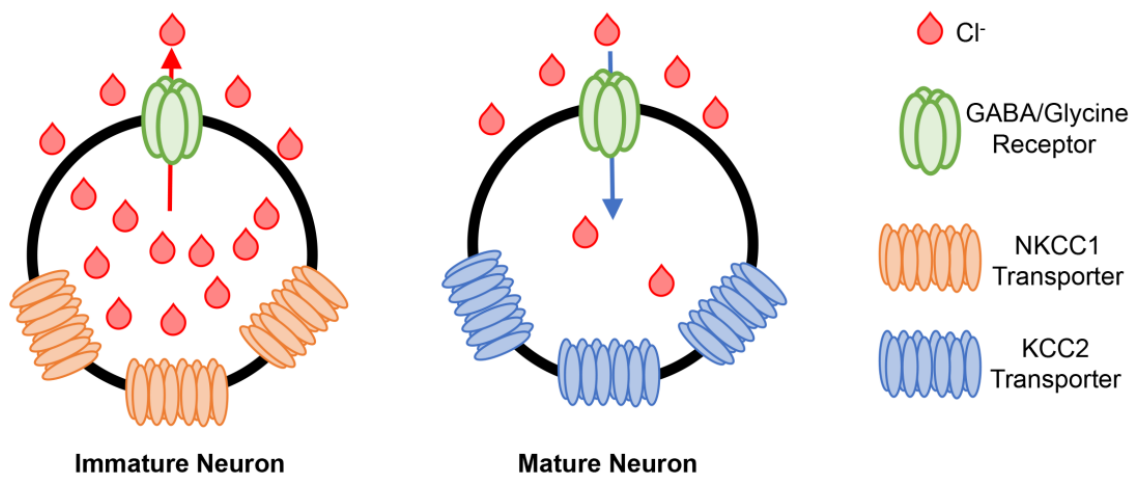
Figure 3. Maturation of neuronal chloride transporters. In immature neurons, chloride (Cl − , red drops) concentrations are higher intracellularly due to the expression of immature NKCC2 transporter (orange). When the ion pore of GABAergic or glycinergic synapses is opened (green), chloride efflux (red arrow) occurs depolarizing the neuron. In mature neurons, intracellular chloride concentration is low, due to the expression of the mature KCC2 transporter (blue). When the ion pore of GABAergic of glycinergic synapses is opened chloride influx occurs (blue arrow), hyperpolarizing the neuron.